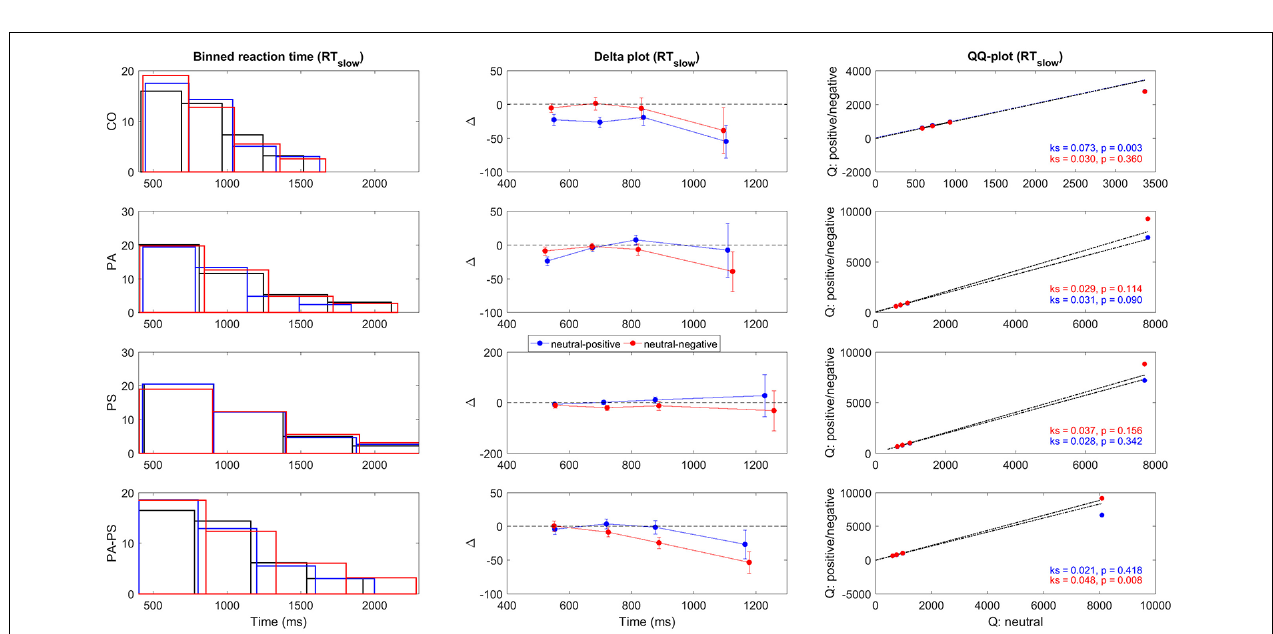
FIGURE 3 | Delta plots RT slow . Illustration of the quantile differences in RT slow per group (CO, PA, PS, PA-PS). First panel: Binned RT slow frequency distributions for the neutral (black), positive (blue), and negative (red) condition. The solid lines indicate edges of the four bins. Second panel: Delta plots of quantile differences ( y -axis, i.e., neutral minus positive, and neutral minus negative) against quantile averages ( x -axis), as computed from the cumulative distribution functions (CDFs). Note the different y -units between RT ( Figure 2 ) and RT slow , adapted for better visibility. See Tables 3 and 4 for statistical analysis. Third panel: QQ-plots of the frequency distributions between the neutral versus the positive (blue) and negative (red) conditions. Statistical significance was assessed using two-sample Kolmogorov–Smirnov test ( k , p -value) comparing the CDFs of the neutral versus the positive and negative conditions.